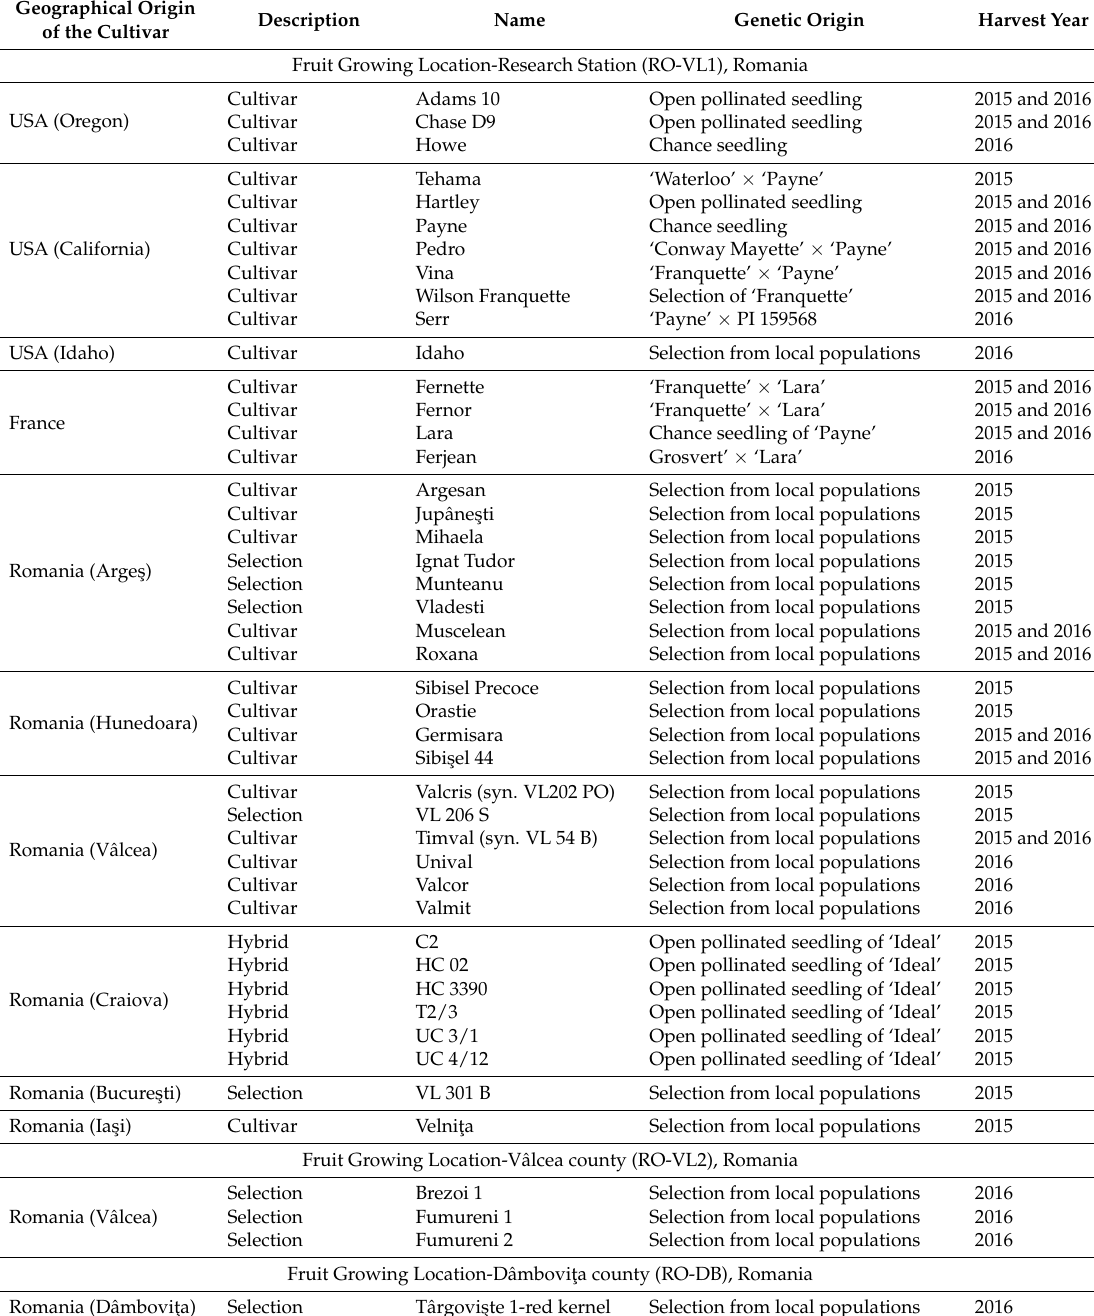
Table 4. Description of walnut samples